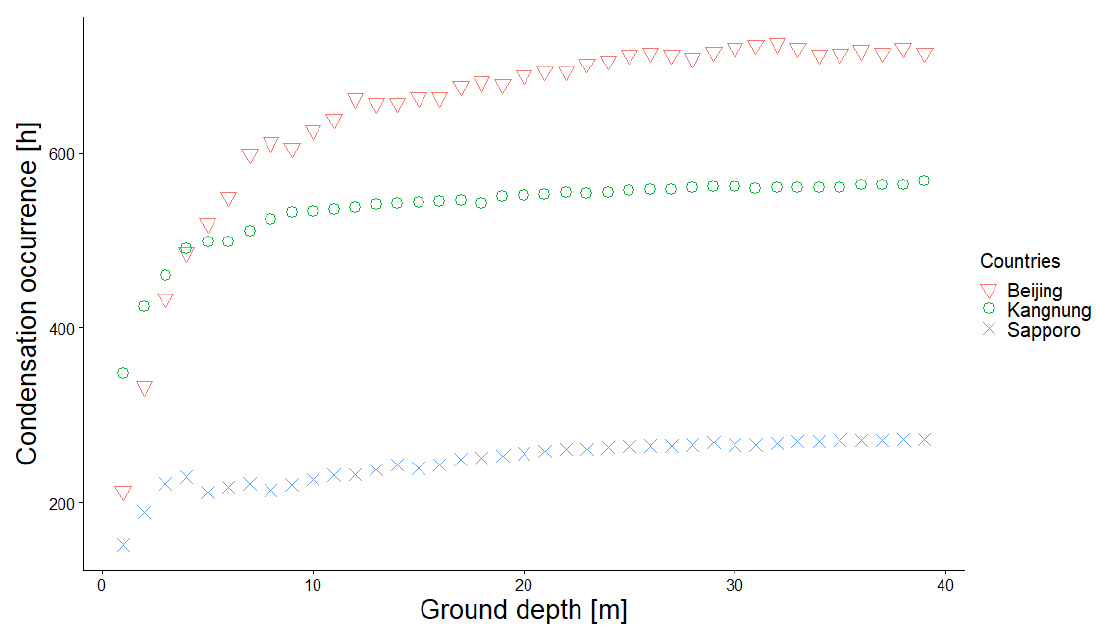
Figure 10. Hours of condensation risk in BSk (Beijing), Dfa (Kangnung), and Dfb (Sapporo).